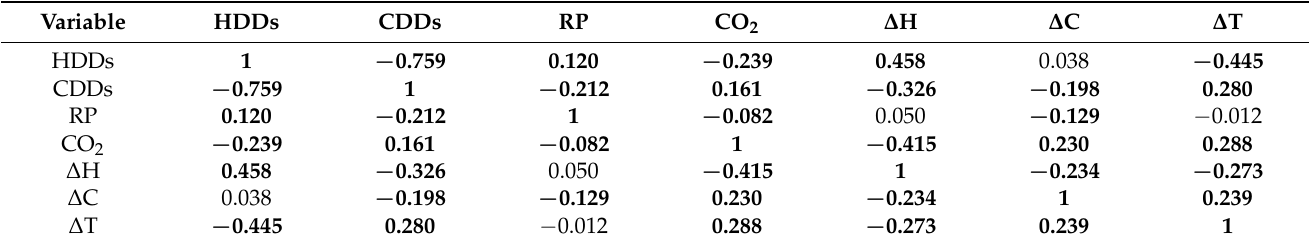
Table 6. Pearson’s r